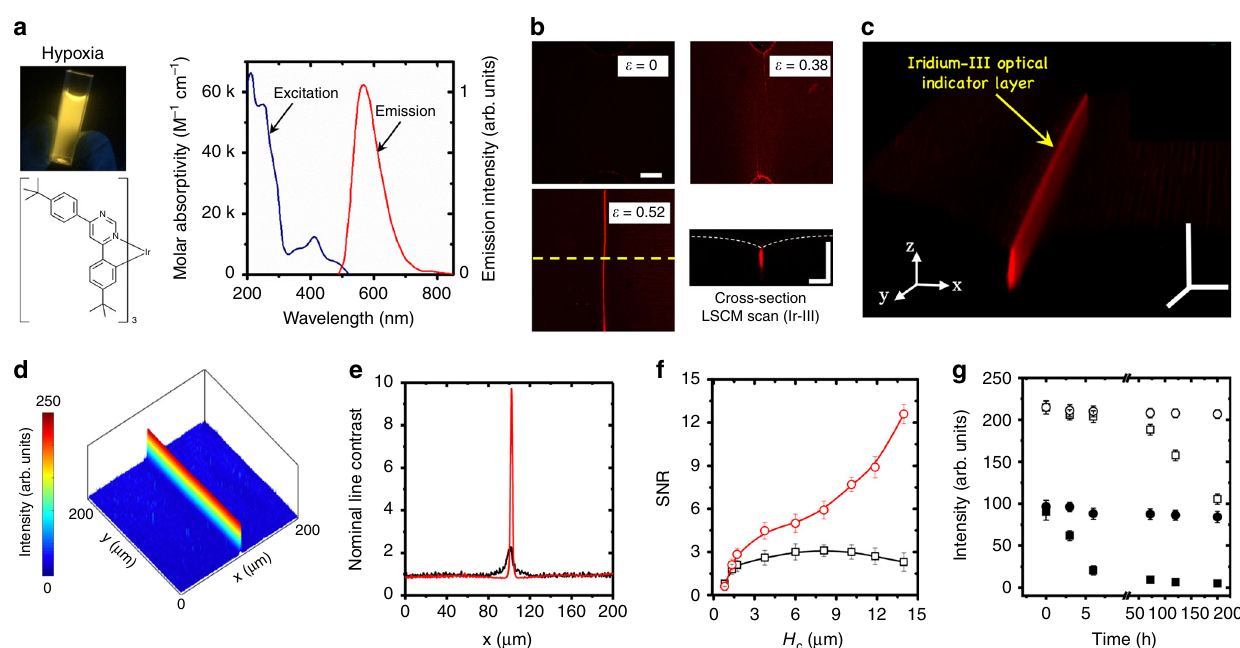
Fig. 2 The generation of ultra-high contrast signal. a Ir-III complex and its excitation and emission spectrum ( b ) Top and cross-sectional views of signal generated by an Ir-III indicator layer; ( c ) A signal image of red blade with ultra-high contrast signal from 3D LSCM reconstruction. d The analysed results for top view signal in the selected image in ( b ). e Comparison of the nominal line contrast (NLC) for the selected areas in ( b ) (red line) and Fig. 1e (green line). f The scaling of signal noise ratio (SNR) versus self-contact depth ( H c ) for fl uorescein o-acrylate (FoA, black symbol) and Iridium-III (IR-III, red symbol). g A time lapsing tracking of signal intensities in ( b ) and Fig. 1e at ε comp = 0.52, circle for FoA, square for Ir-III, hollow for the peak signals, solid for the background signals. All scale bars are 30 μ